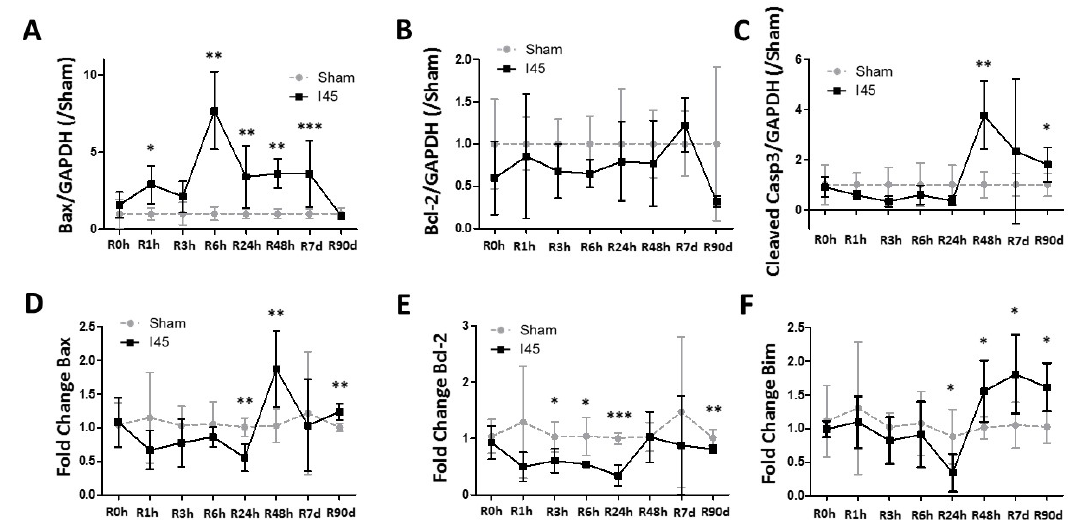
Figure 3. Apoptosis increases post reperfusion following mild ischemia. Rats, either Sham-operated (Sham) or subjected to 45 min of renal ischemia (I45), were sacrificed at various time points post reperfusion (R0h, R1h, R3h, R6h, R24h, R48h, R7d, and R90d). Kidney tissue was collected and analyzed by Western blotting for Bax ( A ), Bcl-2 ( B ), and Cleaved Caspase 3 ( C ), and by qPCR for the mRNA expression of Bax ( D ), Bcl-2 ( E ), and Bim ( F ). * p <0.05, ** p < 0.01, *** p < 0.001. N = 6.